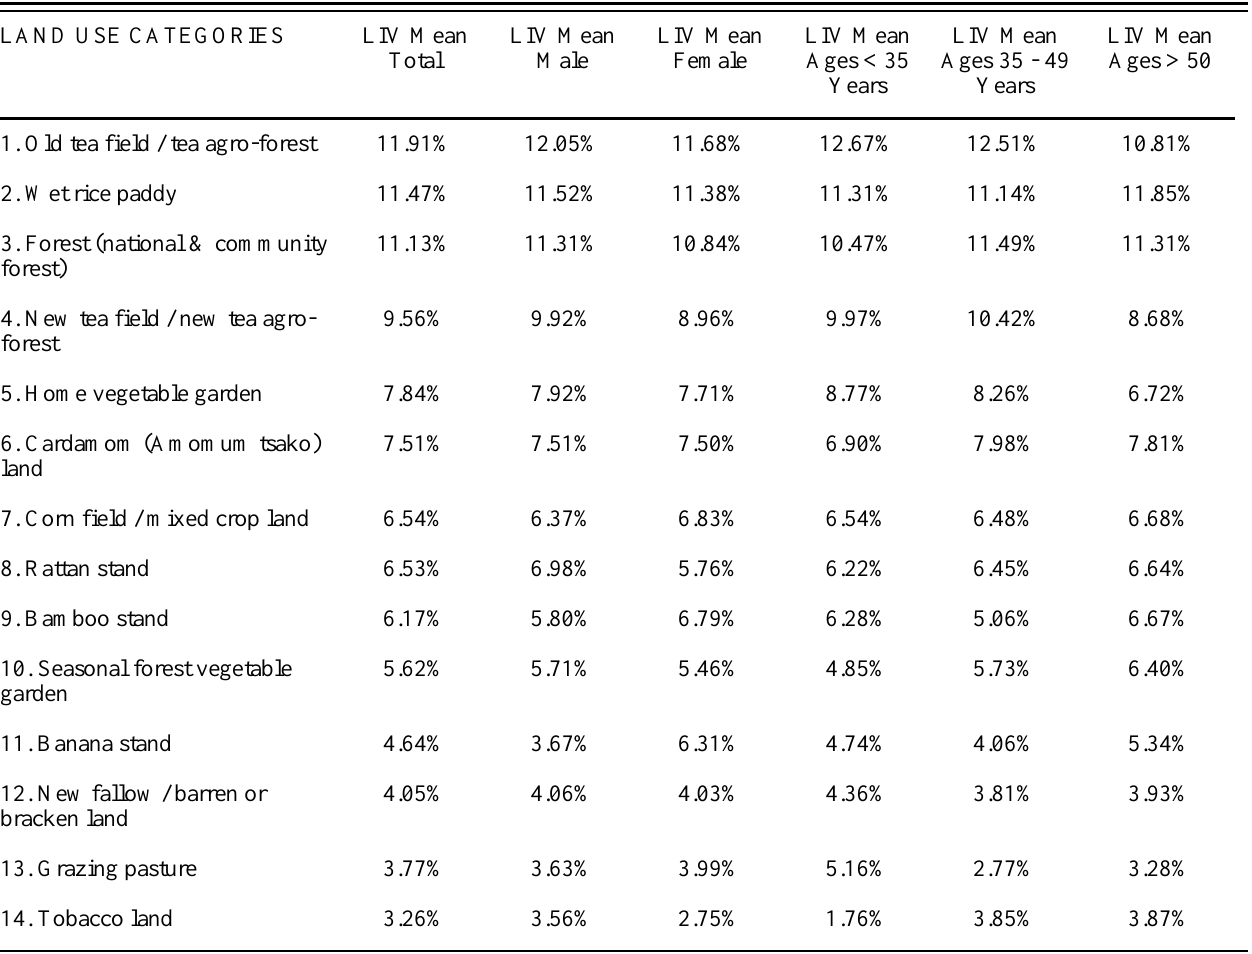
Table 2. Mean Land use Importance Values (LIVs) by informant gender and age-class elicited in Buljalpuxeevq in